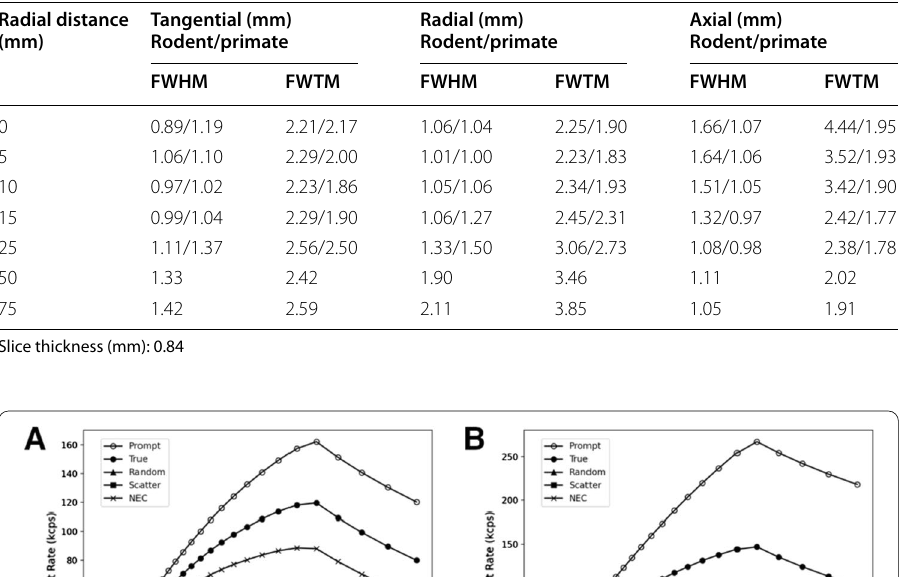
Table 2 FWHM and FWTM at one quarter from the axial center resolutions at different radial positions